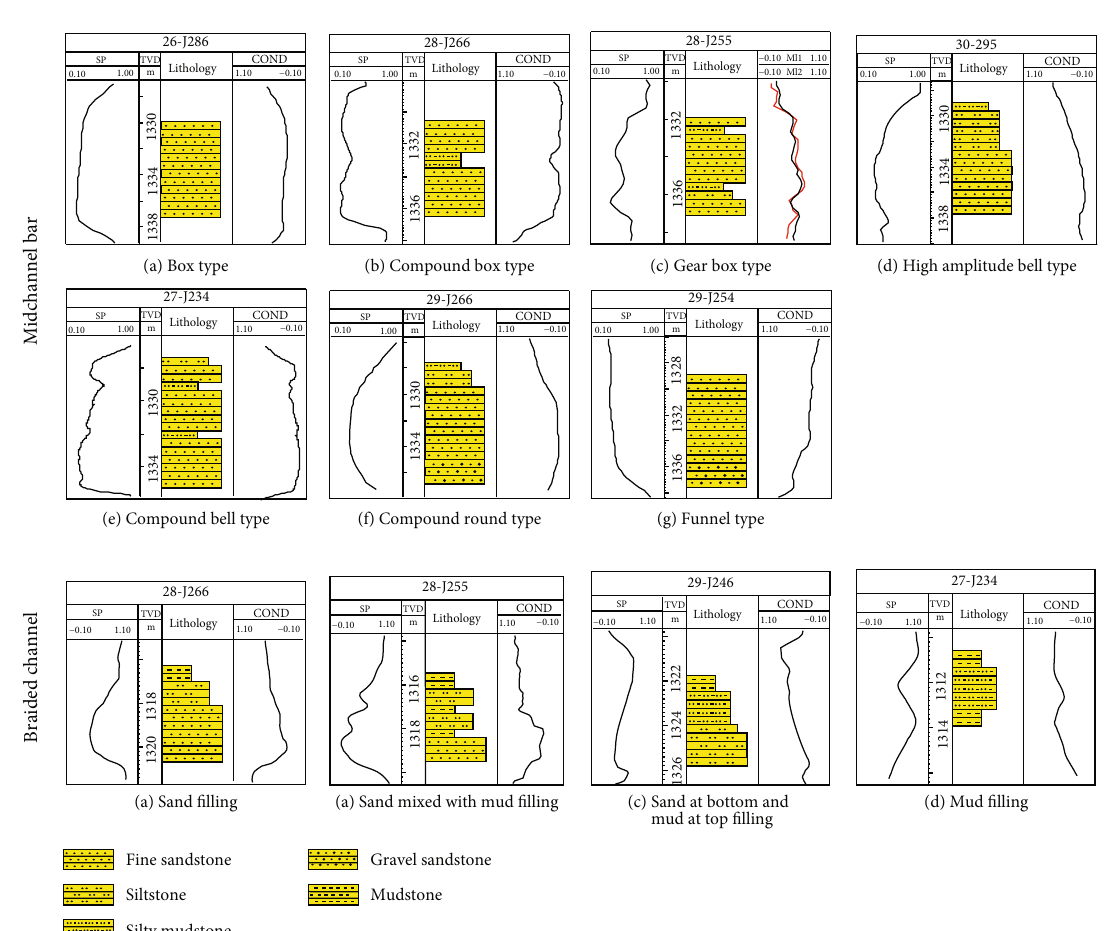
Figure 5: Types of midchannel bar and braided fi lling